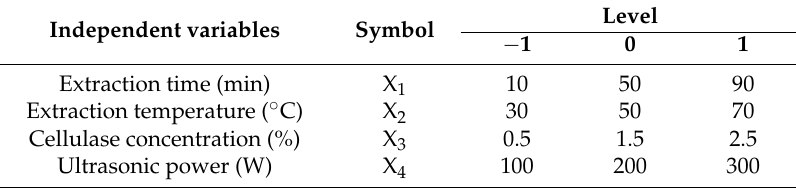
Table 5. Independent variables and their levels in Box-Behnken